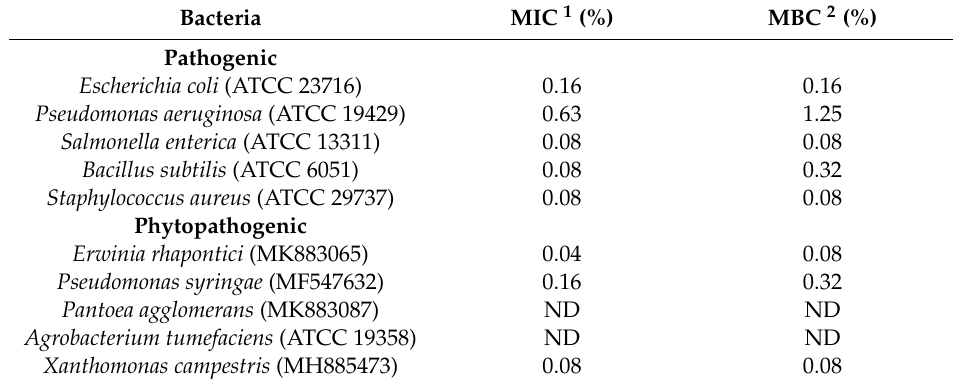
Table 4. Antibacterial activity of Origanum vulgare essential oil from Putre, Chile. Bacteria MIC 1 (%) MBC 2 (%)